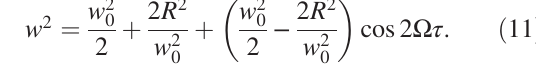
¼ r 0 m , and mis-